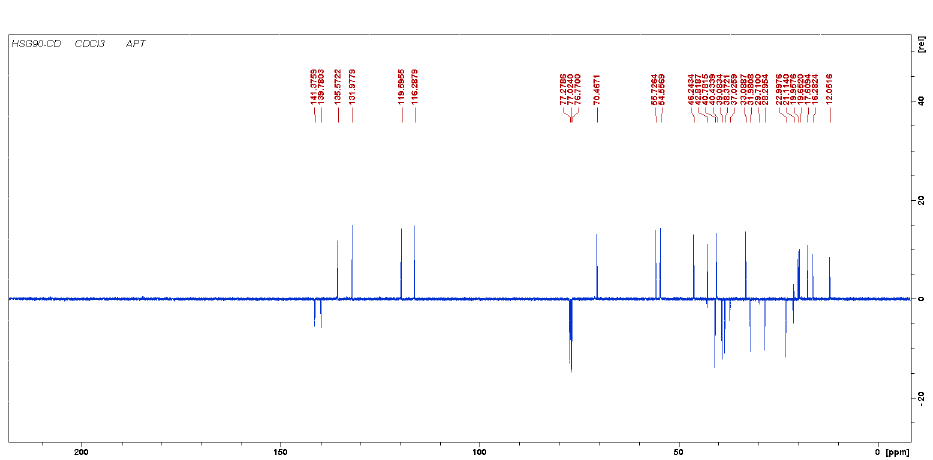
Figure A2. Analysis of main compounds with retention times of 40 min in HPLC by 13 C NMR.